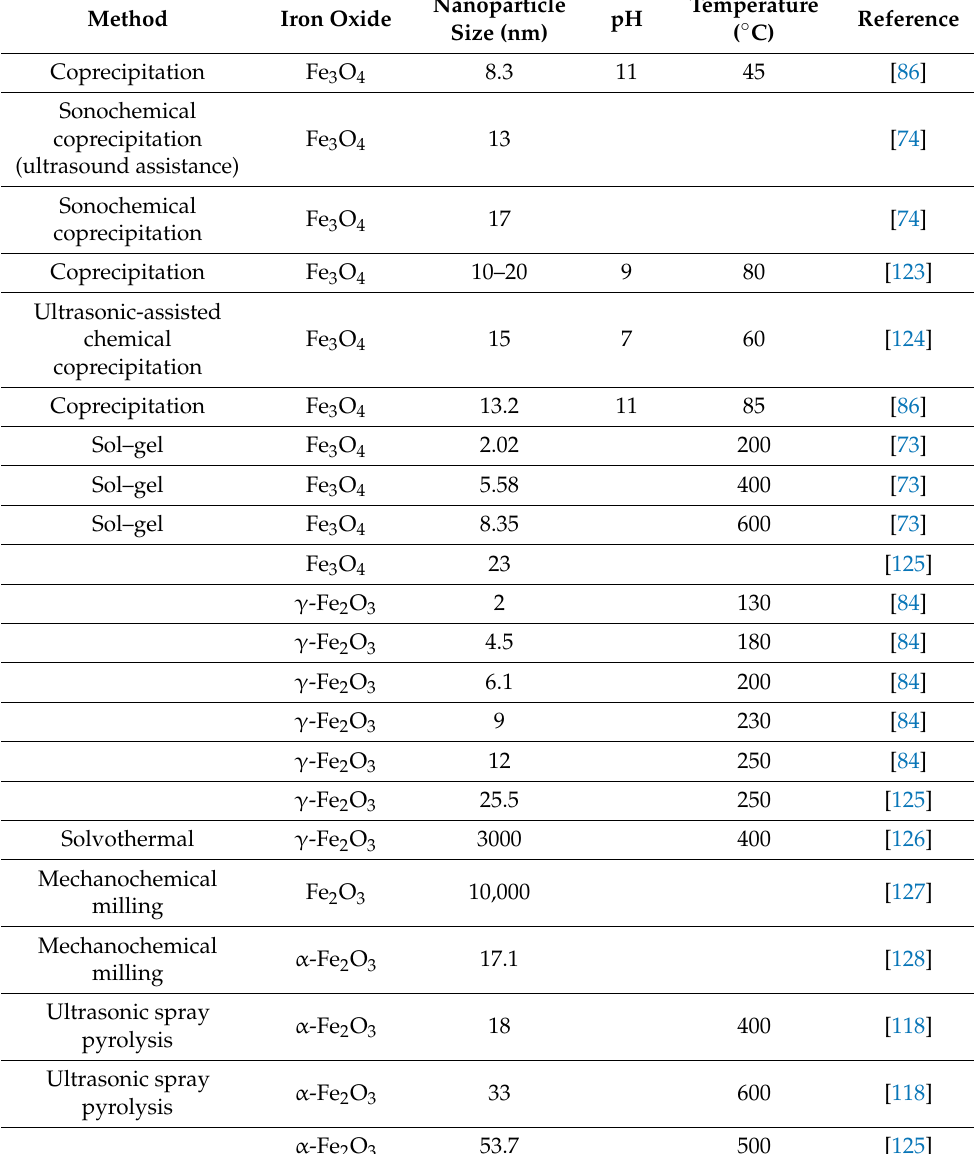
Table 4. Synthesis methods for bare iron oxide nanoparticles’ sizes under various